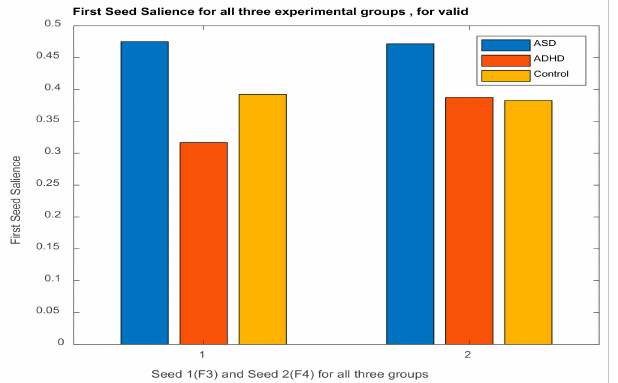
Figure 20. Plot of first seed salience vs. seeds 1 and 2 (MSE values at F3 and F4, respectively), for all groups, in the valid